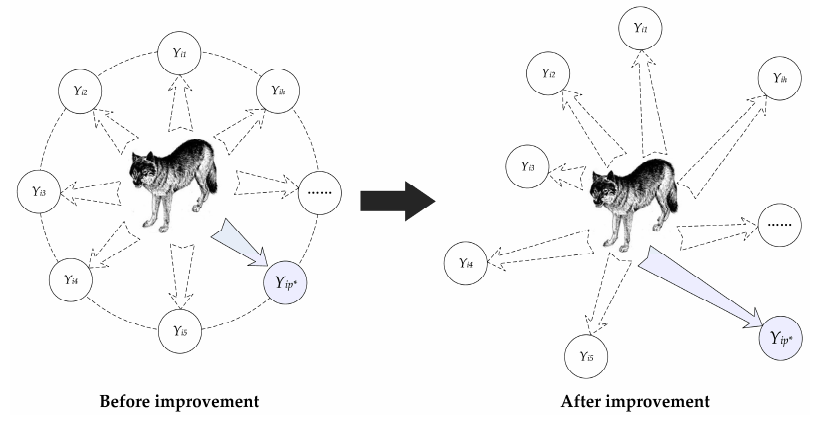
Figure 9. Schematic diagram of random walk search.